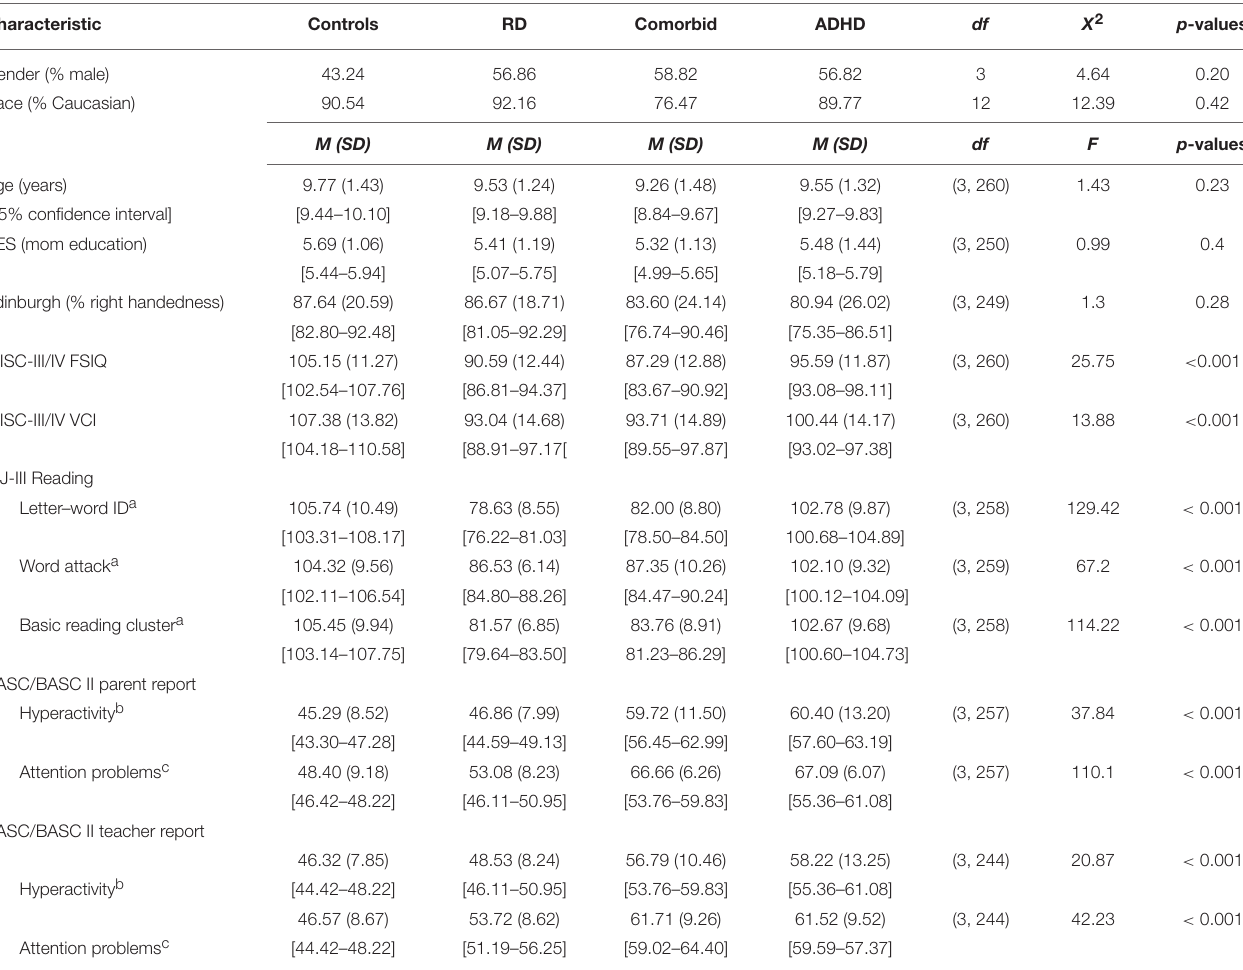
TABLE 1 | Participant demographic